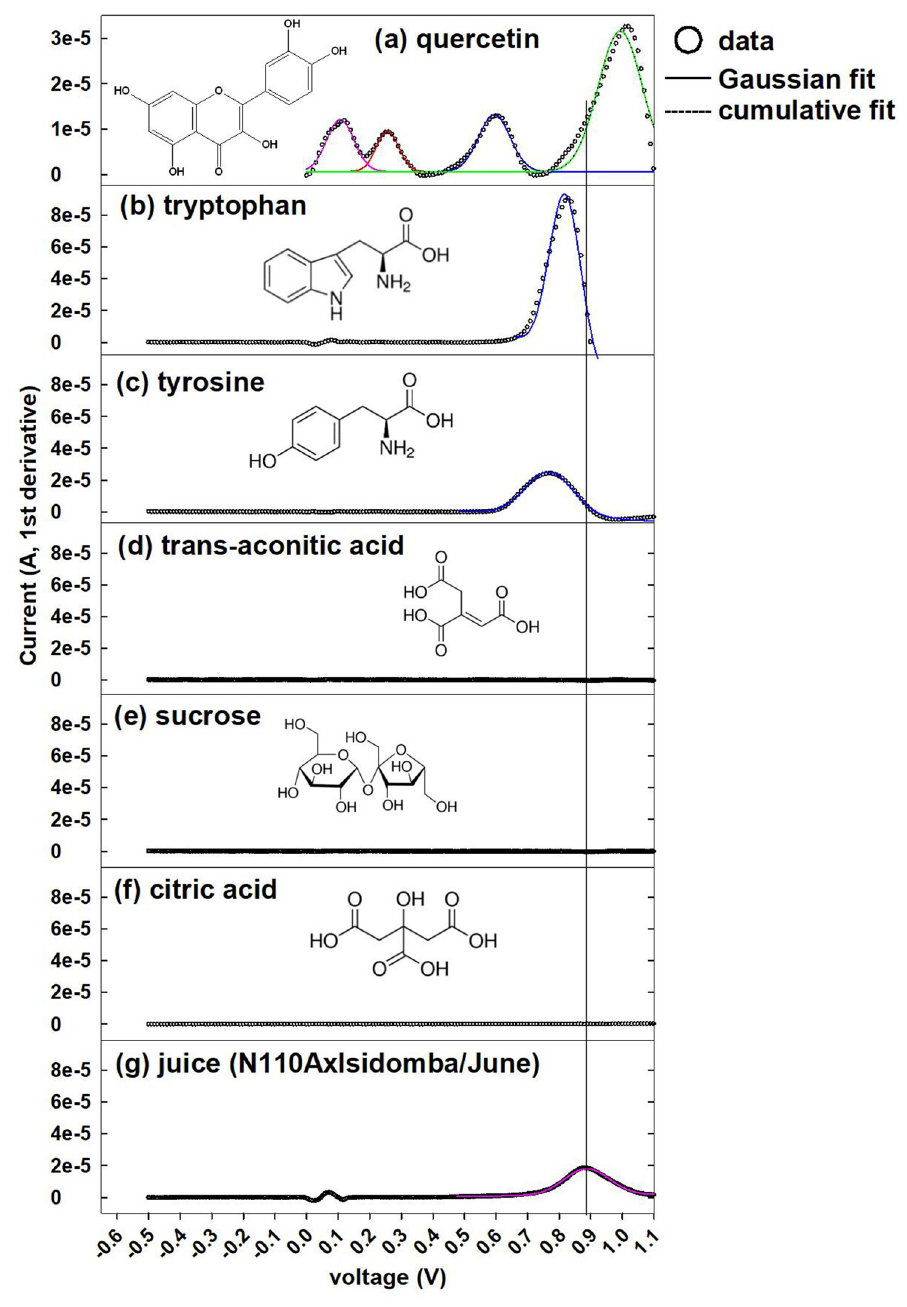
Fig 1. Raw CV (circles; after background subtraction and first derivative with smoothing) and Gaussian fits (colored lines) of 1 mM standards in DDW (a-f, quercetin (literature value) is 0.5 M in ethanol) [7] and representative juice sample (g) using 2 mm carbon SPE. Horizontal line represents E pa of juice (0.81V in Table 2). methods. Hendrickson et al. (1994) attributed three observable anodic peaks of quercetin to hydroxyl groups on the catechol B-ring, C-ring, and A-ring, towards more positive potentials [29]. Brett and Ghica (2003) observed a fourth peak originating from the second–OH on the catechol B-ring [30]. In the literature, total number of CV peaks for a given compound